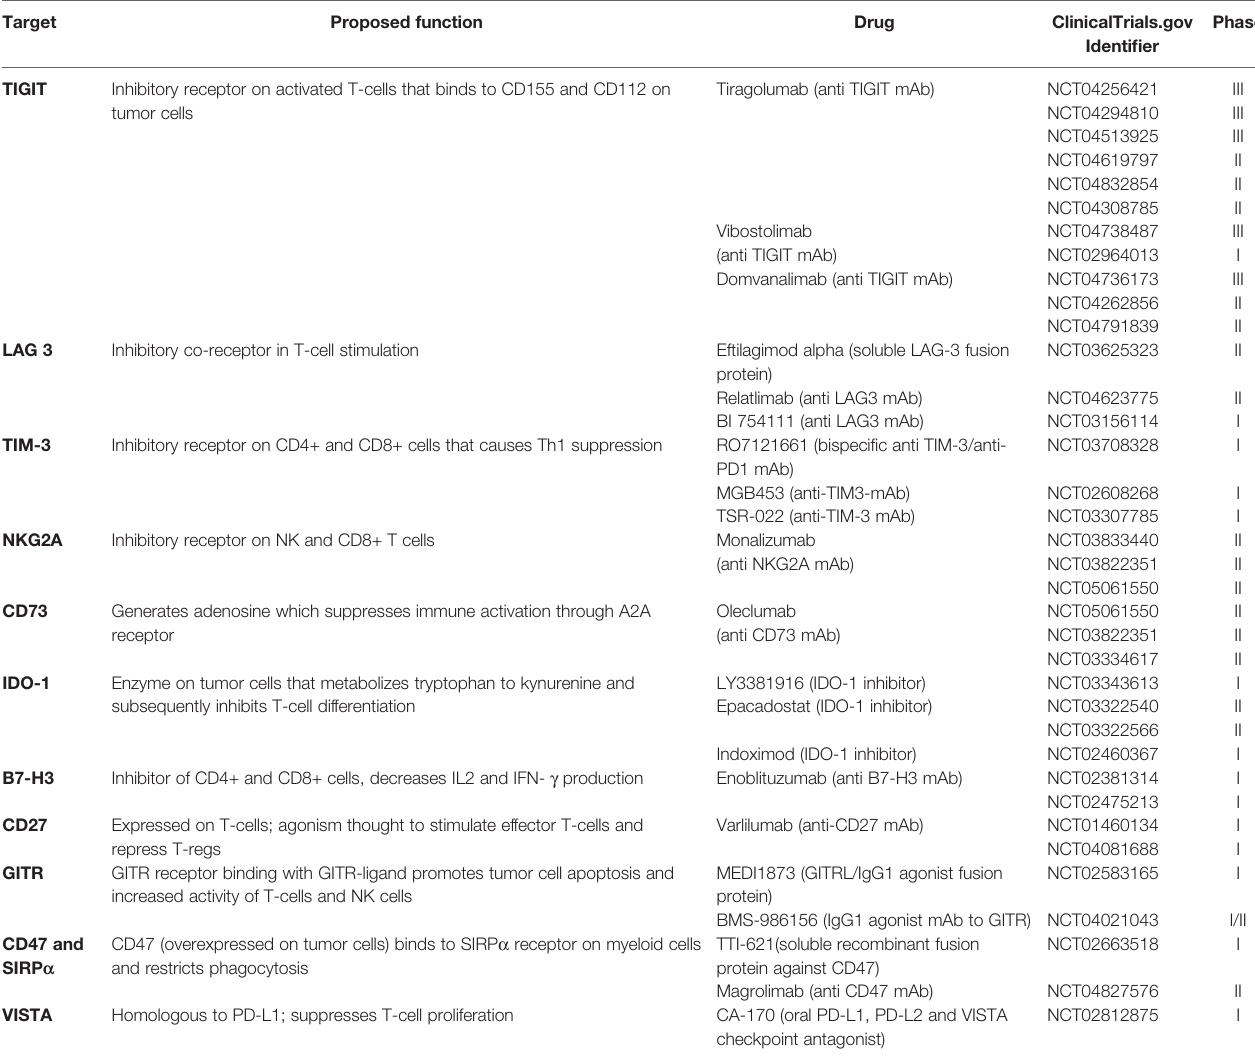
TABLE 1 | Novel immune checkpoint inhibitors and ongoing clinical